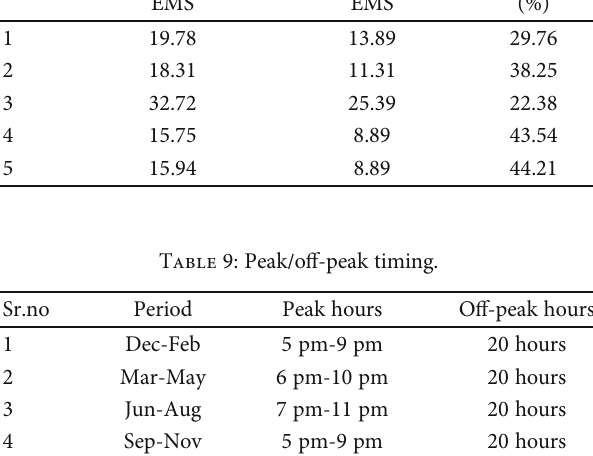
Figure 28: Overall system losses and e ffi ciencies.